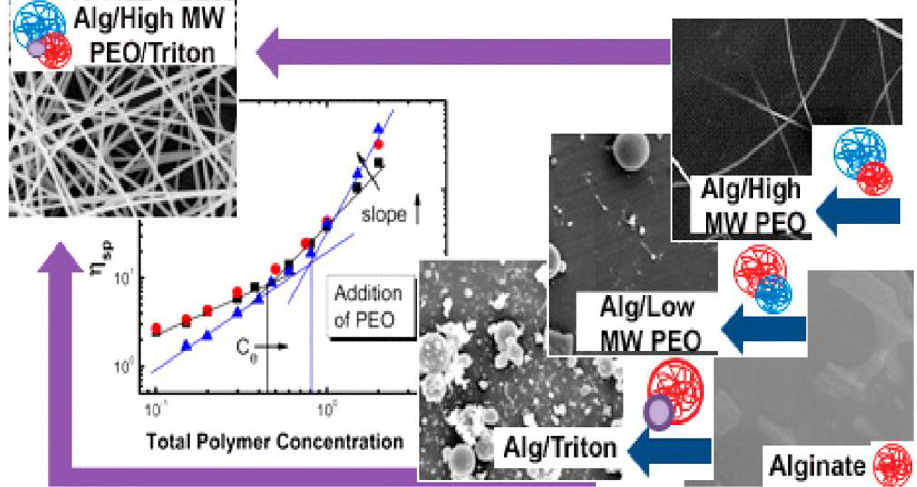
Figure 4. Schematic for the synthesis of alginate–polyethylene oxide blend nanofibers and the role of the carrier polymer in electrospinning. Reprinted with permission from Ref [121]. Copyright American Chemical Society, 2013.